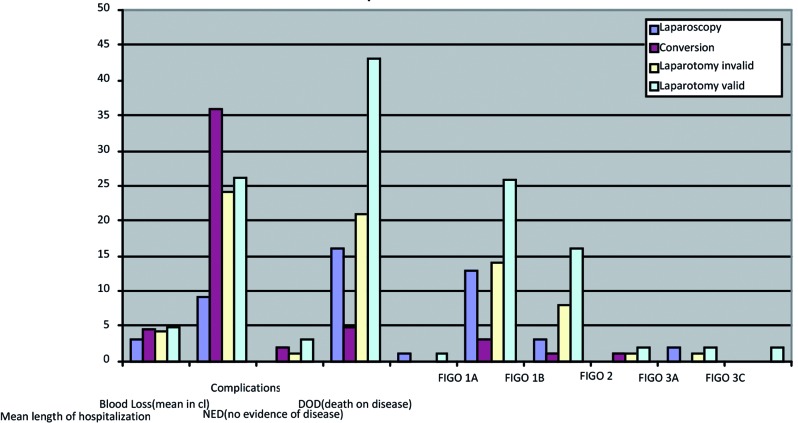
— Clinical relevant post-operative baseline characteristics. The left part of this figure shows different surgical procedures (laparoscopy is group I; conversion is group II, laparotomy invalid is group IIIa and laparotomy valid is group IIIB) in respect to postoperative baseline characteristics in patients that were operated because of endometrial cancer in this study (length of hospital stay, blood loss, overall complications, follow up). The right part shows these different surgical procedures in respect to FIGO stages of endometrial cancer.